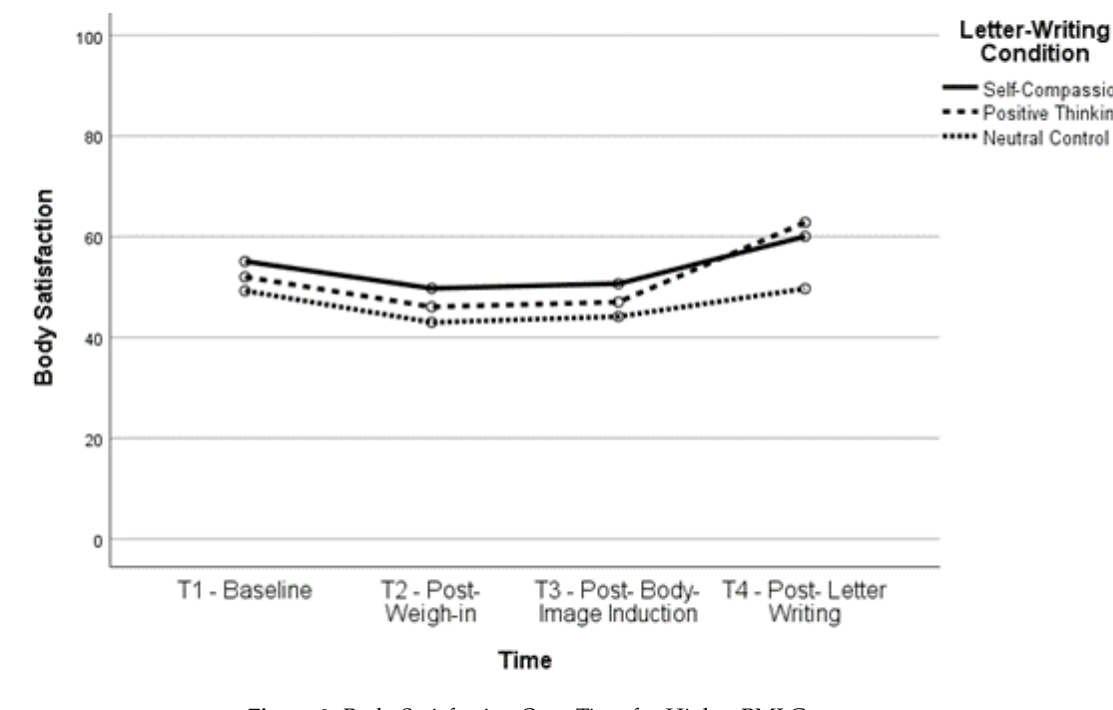
Figure 2. Body Satisfaction Over Time for Higher BMI Group.